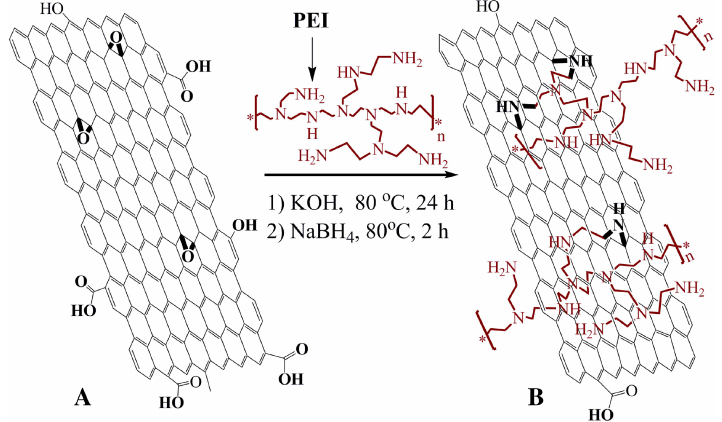
Figure 12. Schematic representation of the functionalization of graphene. ( A ) graphene oxide sheet; ( B ) PEI-funtionalized graphene. This composite was prepared firstly by stirring PEI and graphene in KOH at 80 ◦ C during 24 h. Then, NaBH 4 was added to the mixture and kept at 80 ◦ C for 2 h. The PEI-functionalized graphene was collected by centrifugation and wash with distilled water. With permission from [97].